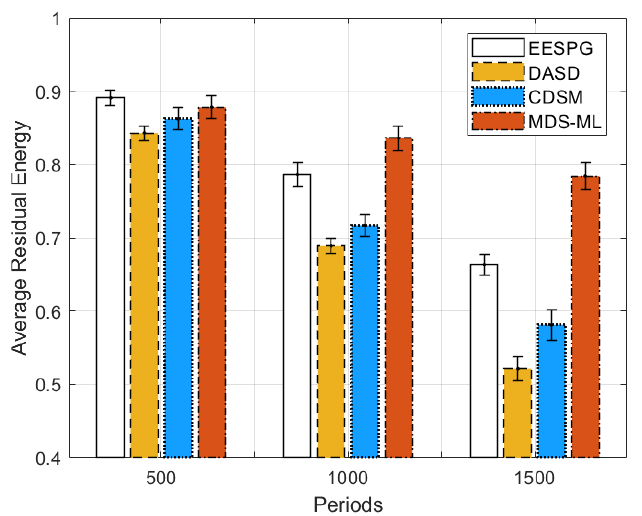
Figure 9. Average residual energy with different number of